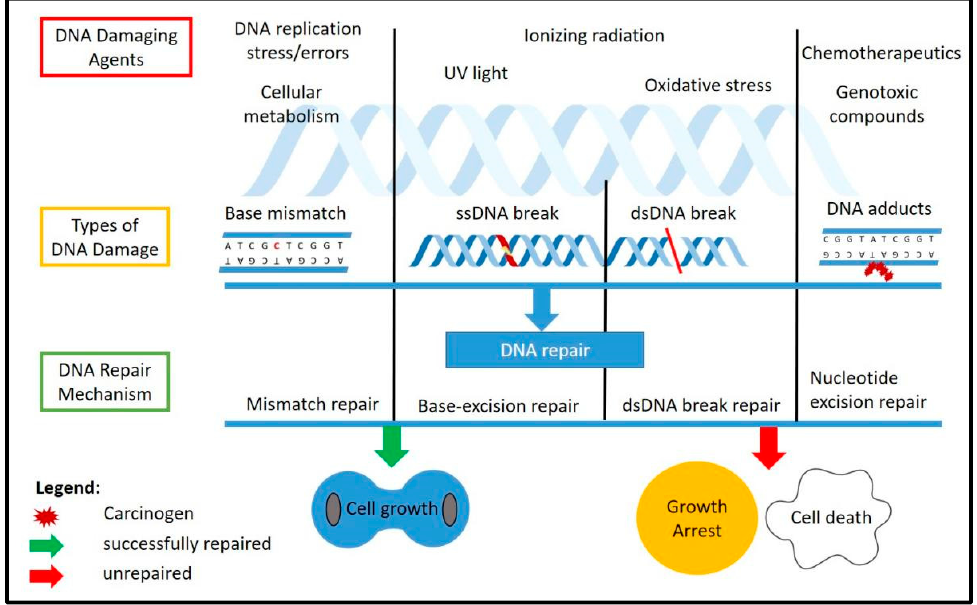
Figure 1. DNA damage and repair mechanisms. The figure illustrates the common DNA damaging agents ( top ), the types of DNA damage caused by these agents ( middle ) and the known response and repair mechanisms involved ( bottom ) as well as the possible outcomes after DNA repair, which include normal cell growth if the repair was successful, and growth arrest or programmed cell death if the damage was unable to be repaired. ss: single-stranded, dd: